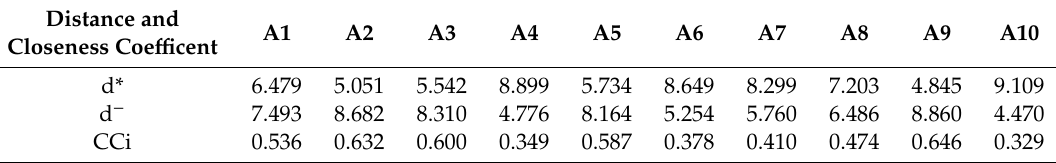
Table 16. Closeness coe ffi cient (CCi).